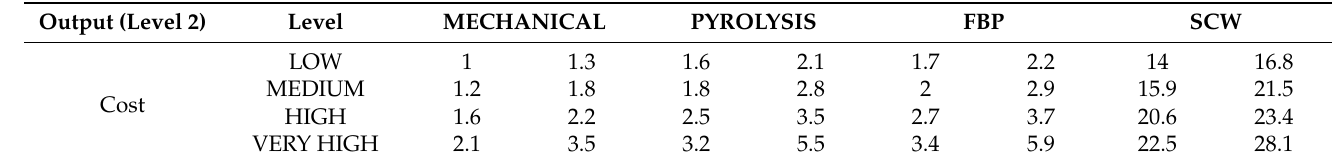
Table 5. Recycling techniques and fuzzy ranges for output cost.